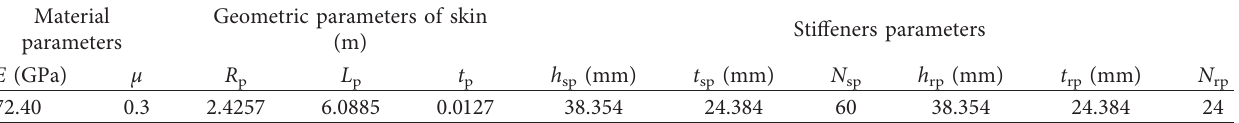
Table 3: Parameters of the longitudinal-ring stiffened cylindrical shell prototype. Material